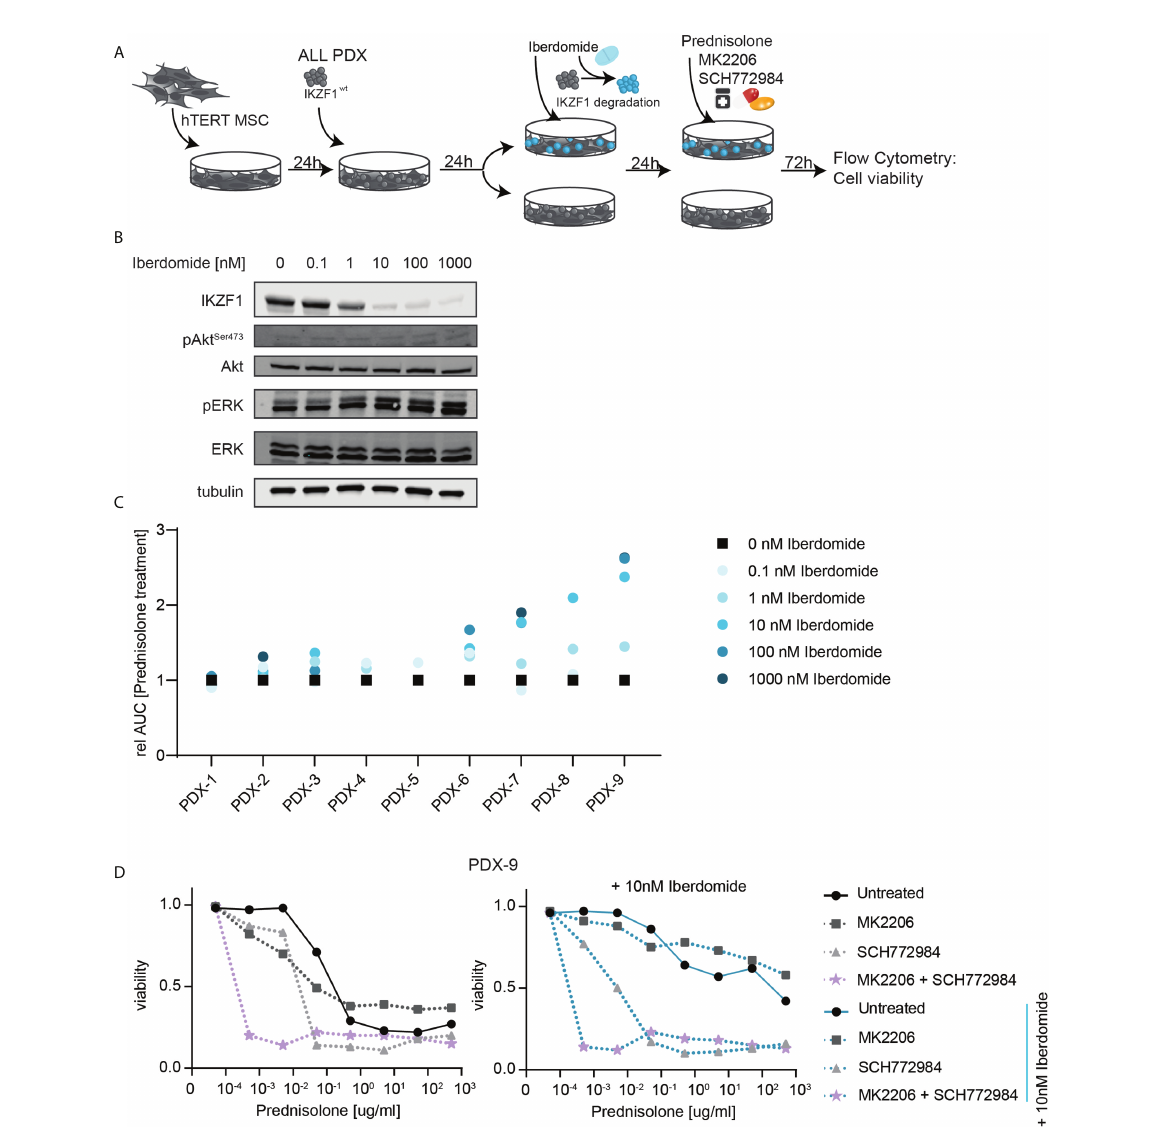
FIGURE 3 (A) Schematic overview representing the work fl ow used to determine ex-vivo prednisolone responses in PDX samples upon iberdomide treatment. ALL PDX samples wild type for IKZF1 were grown on a feeder layer of hTERT immortalized mesenchymal stem cells (MSCs) and left untreated or exposed to the IKZF1 degrading drug Iberdomide. Then cells were treated with increasing concentrations of prednisolone in the presence or absence of MK2206, SCH772984 or their combination. After 3 days of incubation cell death was determined by quanti fi cation of cells positive for amine-reactive dyes using fl ow cytometry. (B) Immunoblot analysis of IKZF1, pAKT and pERK protein expression in a representative PDX sample wildtype for IKZF1 in response to iberdomide (24h). (C) Relative sensitivity to prednisolone of iberdomide treated cells. PDXs wt for IKZF1 were treated with indicated concentrations iberdomide after which responses to prednisolone were determined by quanti fi cation of cells positive for amine-reactive dyes using fl ow cytometry. The AUC of iberdomide treated cells was divided by the AUC of control treated cells to determine changes in sensitivity to prednisolone following iberdomide treatment. (D) Prednisolone induced cell death as determined by quanti fi cation of cells positive for amine-reactive dyes using fl ow cytometry in PDX-9. Cells were either pre-treated with 10 nM Iberdomide or left untreated for 24h before they were treated for 3-days with increasing concentrations of prednisolone in combination with MK2206 and/or